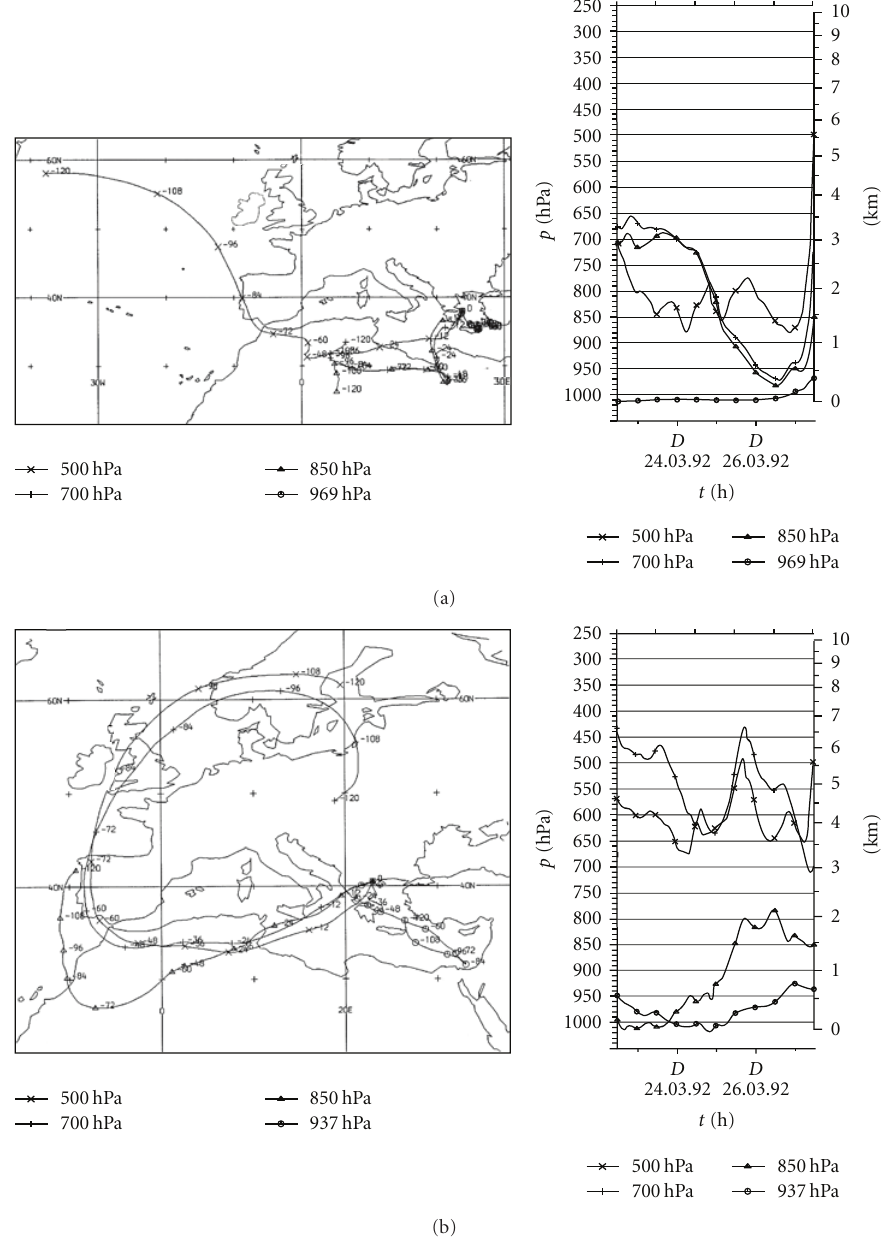
Figure 8: Backward trajectories with arrival (starting) point of (a) Athens (23.72 ◦ E, 37.97 ◦ N) and (b) Thessalonica at 12:00 UTC on 27 March 1992. Left part shows geographical positions and time (hours from the arrival time), and the right part shows vertical positions and